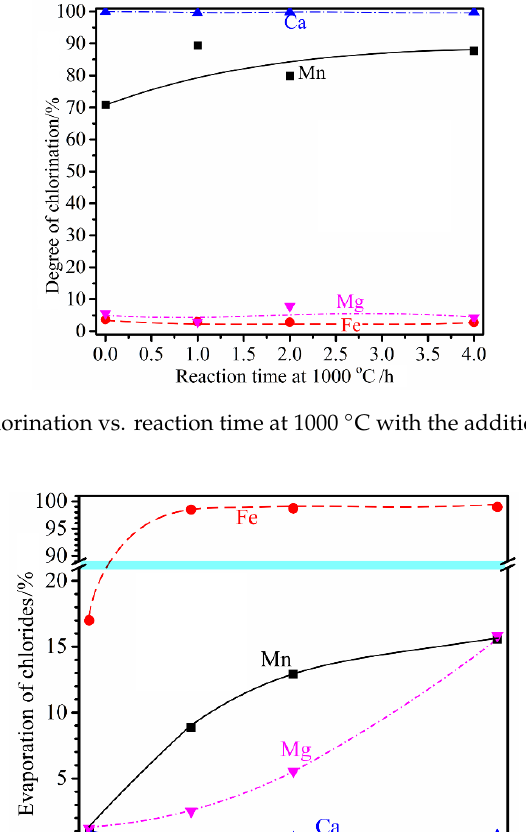
Figure 15. Evaporation degrees of metal chlorides vs. reaction time at 1000 °C with the addition of 20 wt% CaCl 2 and 40 wt% MgCl 2 .